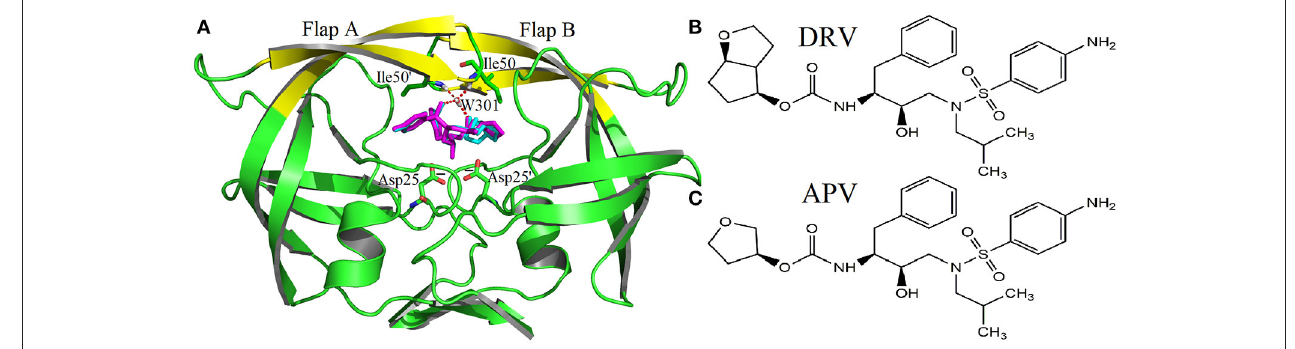
FIGURE 1 | The native structures of molecular: (A) complexes of PR2 and two inhibitors (DRV is cyan, APV is magenta); (B) Inhibitor DRV; (C) Inhibitor